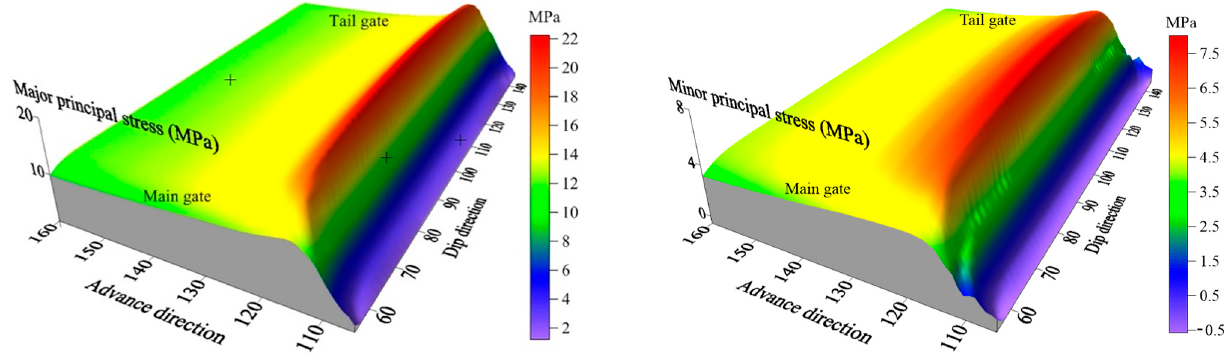
Figure 11. Spatial distribution of the principal stresses on the measuring plane. The two-dimensional distribution of the principal stresses along the monitoring line is displayed in Figure 12, where a positive number on the horizontal axis means top-coal locates ahead of the face line while a negative number means at the rear of the face line. Peak values of the major and minor principal stresses, appearing in front of the longwall panel, are 23 MPa and 7.5 MPa, respectively, corresponding to 2.3 and 2.5 times the pre- mining stress. The peak location of the former is 2 m closer to the longwall face than that of the latter. After the minor principal stress has arrived at the peak location, its magnitude drops drastically because of the coal seam extraction. Decrease of the minor principal stress results in fast deterioration in the compressive strength of the top-coal. Strength loss leads to strain-softening behaviour of the top-coal, which means shear fail occurs at this deformation stage. At the face line, the minor principal stress decreases to